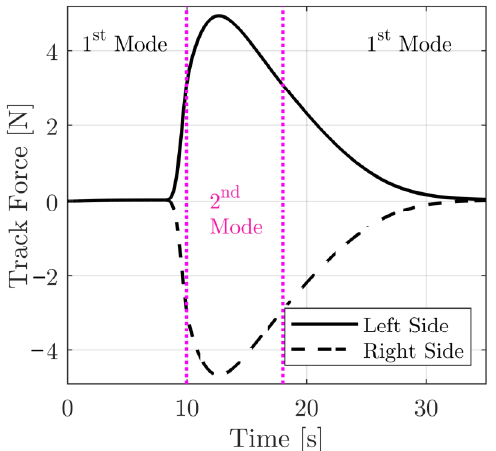
Figure 7. Track forces.